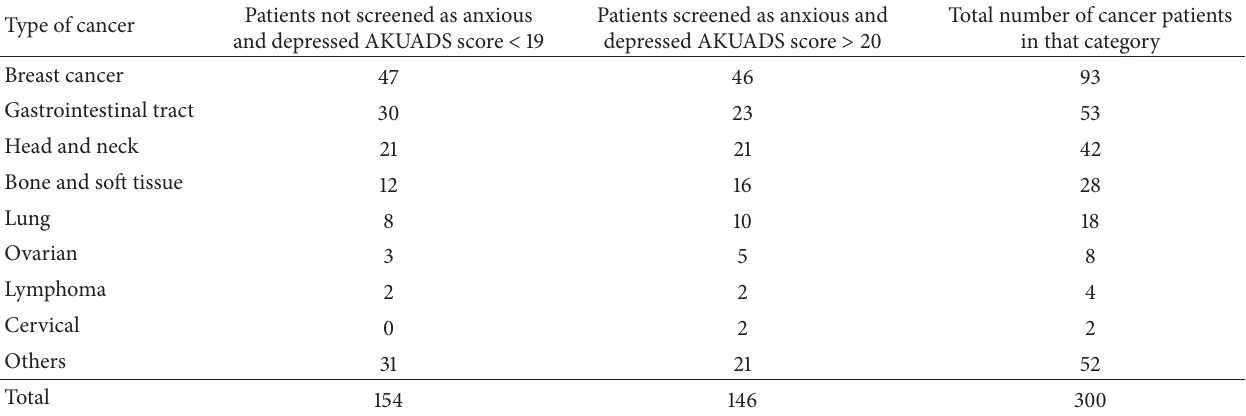
Table 1: Frequency of various types of